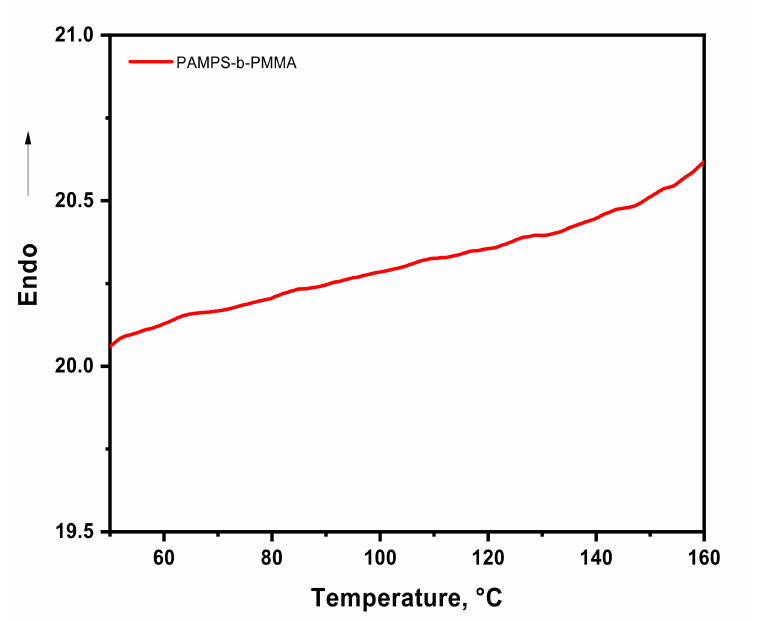
Figure 2. The DSC second-heating curve of PAMPS- b -PMMA